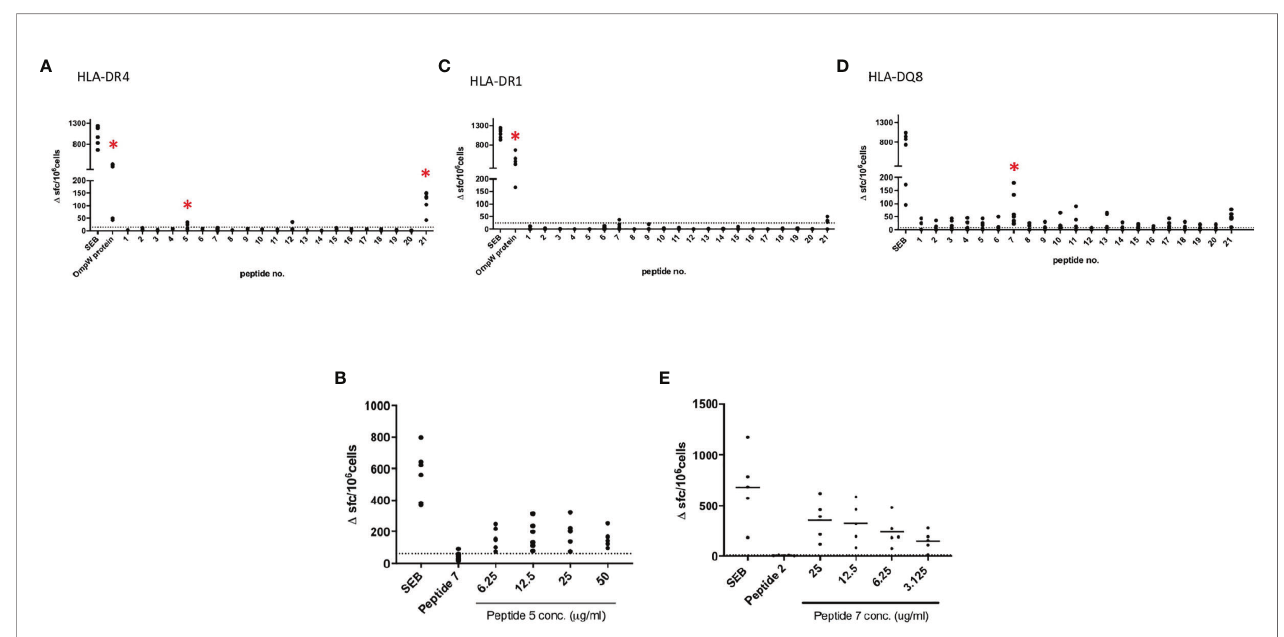
FIGURE 5 | BpOmpW (homologue OmpW in Burkholderia pseudomallei ) induced the production of IFN- g in HLA-DR and HLA-DQ (human leukocyte antigen DR and DQ isotypes, respectively) transgenic mice. Immunization of HLA-DR and HLA-DQ transgenic mice highlights HLA class II determining immunodominant epitopes of BpOMpW. (A – C) Mice transgenic for HLA-DR4 ( n = 6), (A) , HLA-DR1 ( n = 6) (B) , and HLA-DQ8 (DQB1*0302) ( n = 6) (C) were primed with 25 m g rBpOmpW and the draining lymph node cells assayed with IFN- g ELISpot in response to the indicated peptide on day 10. Data are plotted as spot-forming cells (SFCs) per 10 6 cells for individual mice. (D, E) Responses to peptide were de fi ned as positive if SFCs are greater than the mean + 2 SD of the response in the absence of any antigen (shown as horizontal dotted line ): n = 6 (D) and n = 5 (E) transgenic mice. The levels of signi fi cance are represented as follows: * p <